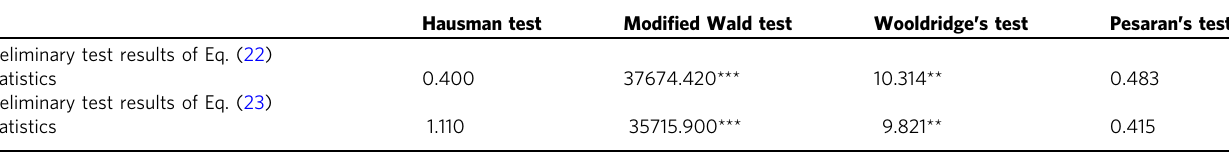
Table 10 Preliminary tests of panel data